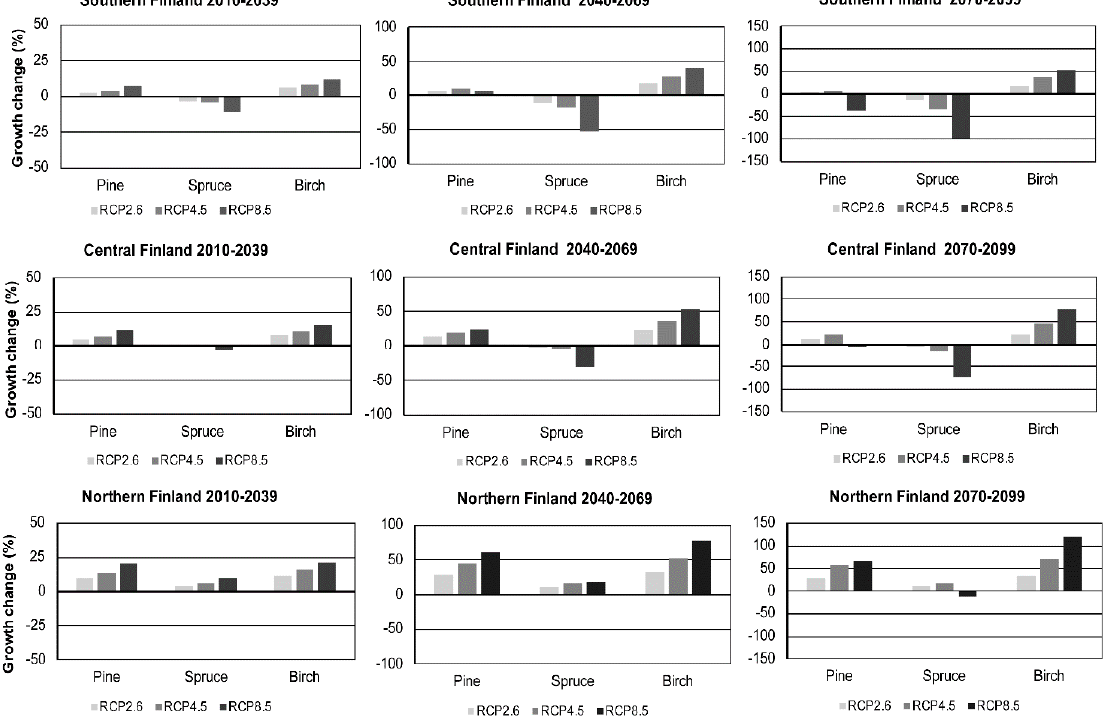
Figure 4. Average percentage changes in the diameter growth of Scots pine, Norway spruce, and birch on the upland forest sites (NFI11 plots) in different temperature sum (southern TS > 1200 d.d., central 1000 d.d. < TS < 1200 d.d. and northern TS < 1000 d.d.) regions in three 30-year sub-periods over the